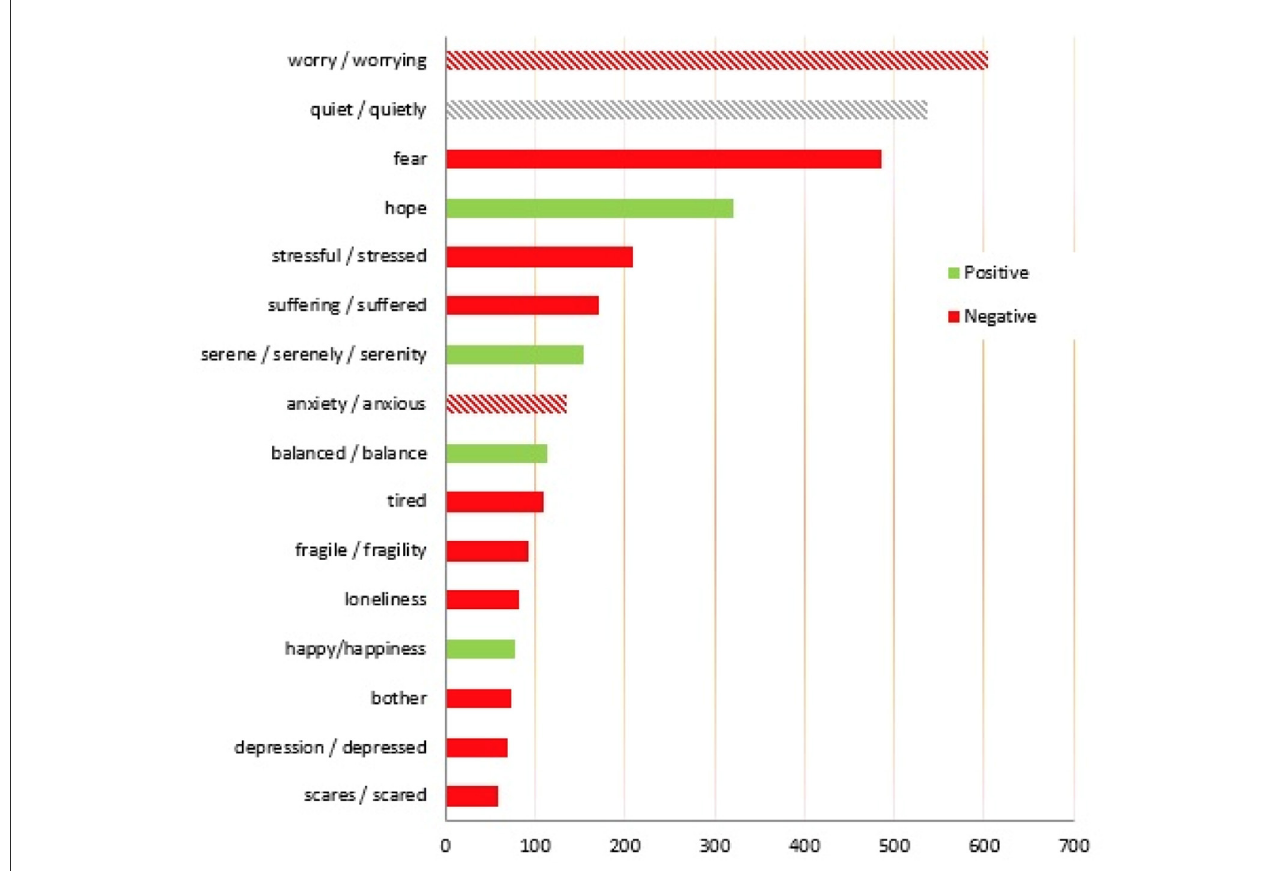
FIGURE1 Words pronounced by the interviewee linked to moods and feelings (number of words >